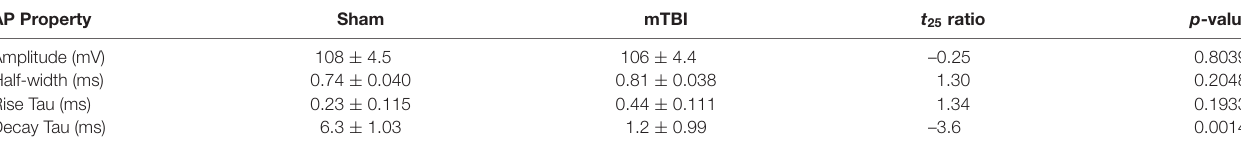
TABLE 1 | Intrinsic action potential (AP) properties of intact yellow fluorescent protein (YFP+) pyramidal neurons 2 days postinjury. AP